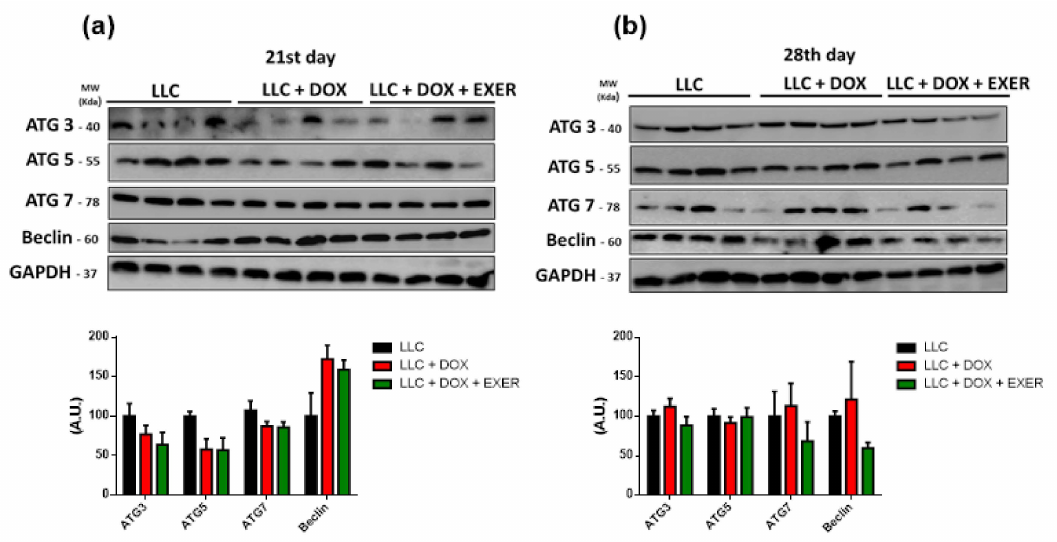
Figure 4. Autophagic signaling in gastrocnemius. ( a ) Expression of proteins involved in autophagic activation at the end of the chemotherapy cycle. ( b ) Expression of proteins involved in autophagic activation after chemotherapy interruption. Values represent the mean and standard error of the mean of the analysis of the data obtained n = 4. LLC = Lewis lung carcinoma; DOX = doxorubicin; EXER = endurance exercise. The uncropped Western Blots are available in Figure